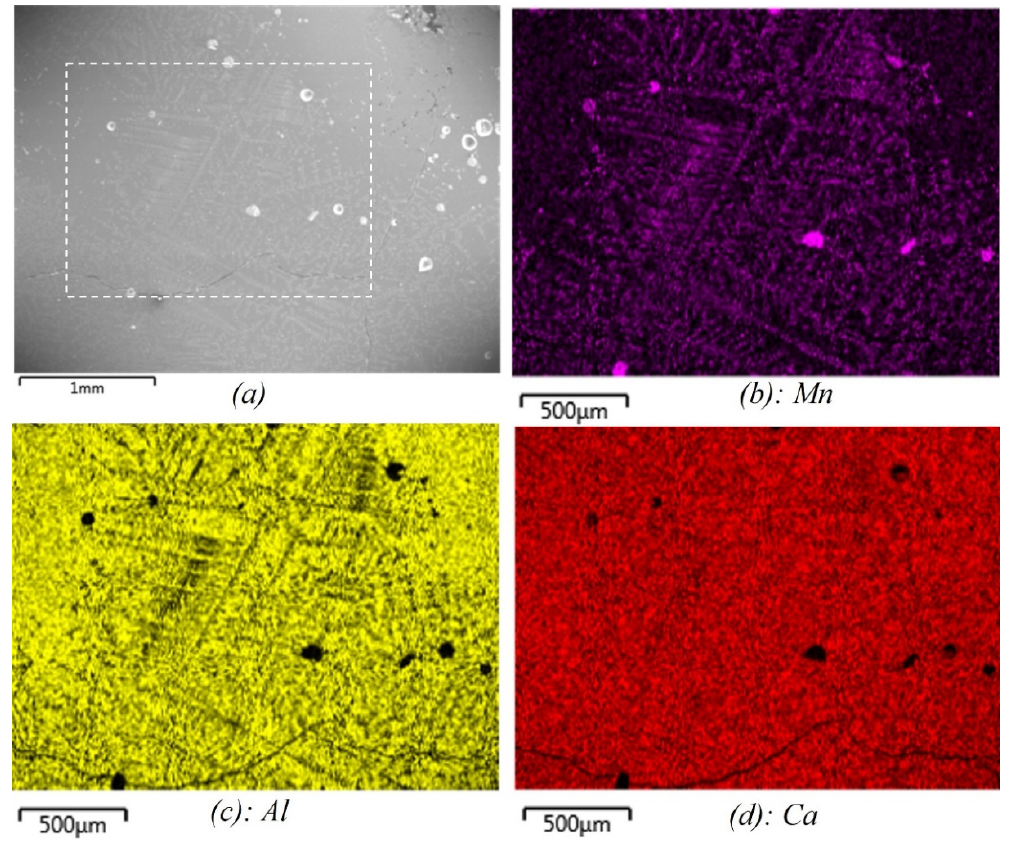
Figure 4. Secondary electron image from the slag ( a ), and the X-Ray mapping of Mn ( b ), Al ( c ), and Ca ( d ) in the selected area in image ( a ).